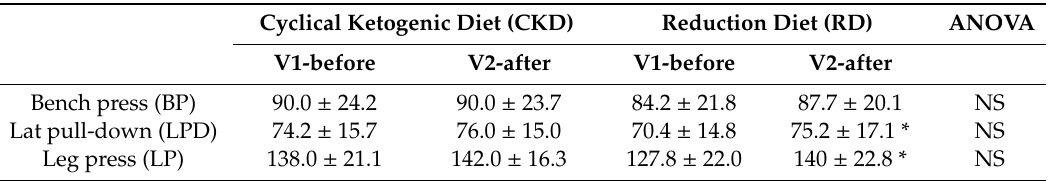
Table 2. The effect of cyclical ketogenic reduction diet and nutritionally balanced reduction diet on strength parameters.